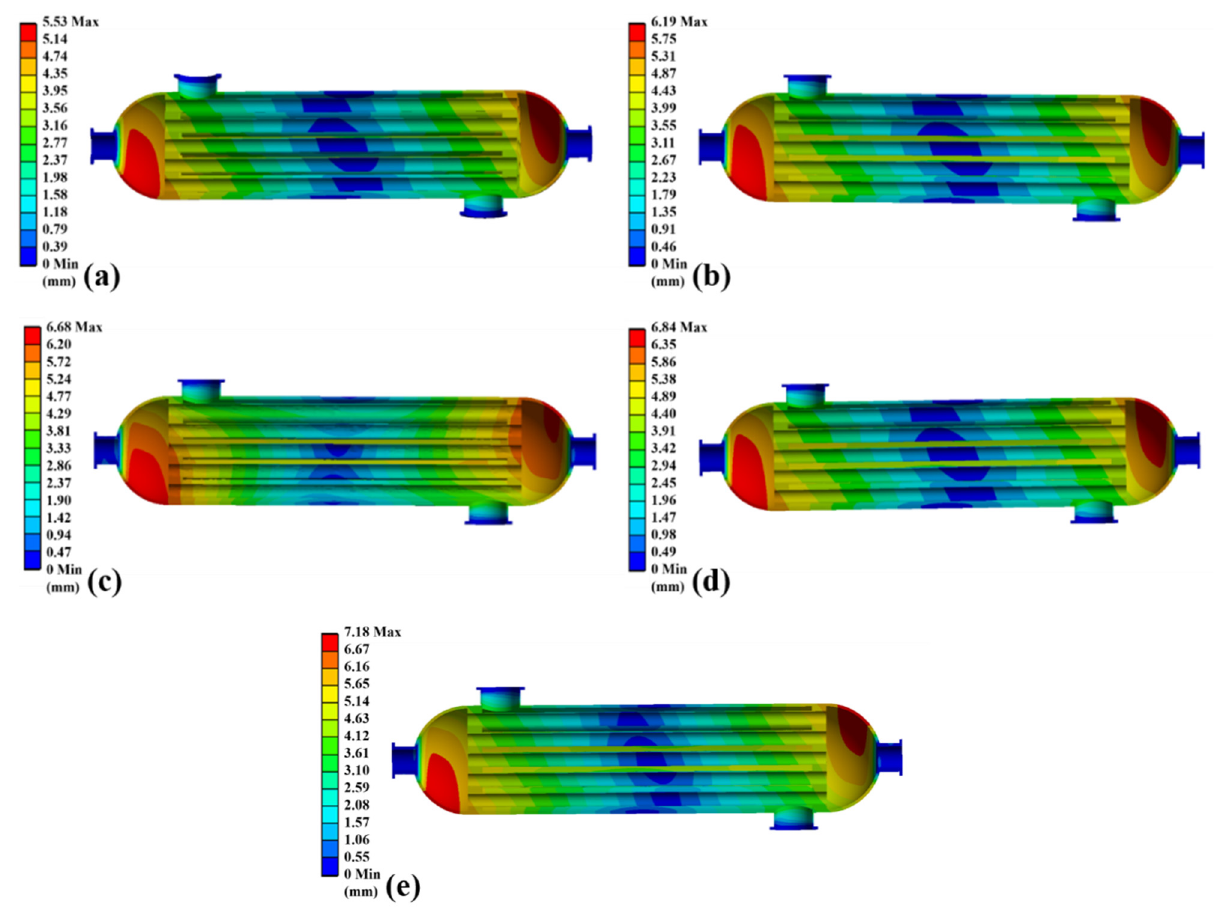
Figure 12. Cloud diagram of superheater deformation distribution at different molten salt inlet tem-